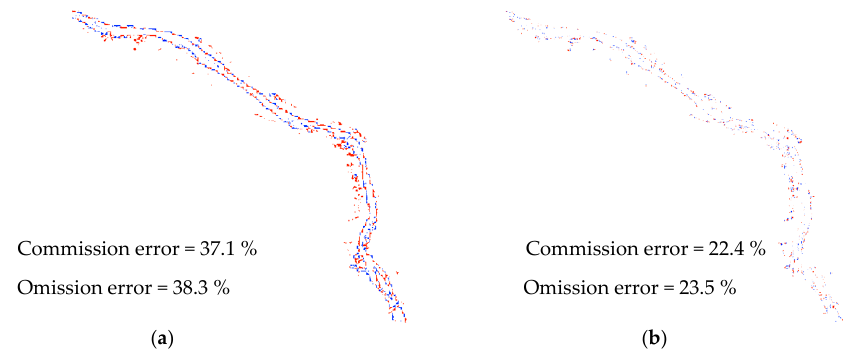
Figure 18. User and producer accuracies of hard classification and SRM algorithms using semi-simulated water fractions across a range of ZF for Noce River; (HC: hard classification, PS: pixel swapping, MBPS: modified binary PS, BL: bilinear, BC: bicubic, L3: lanczos3).